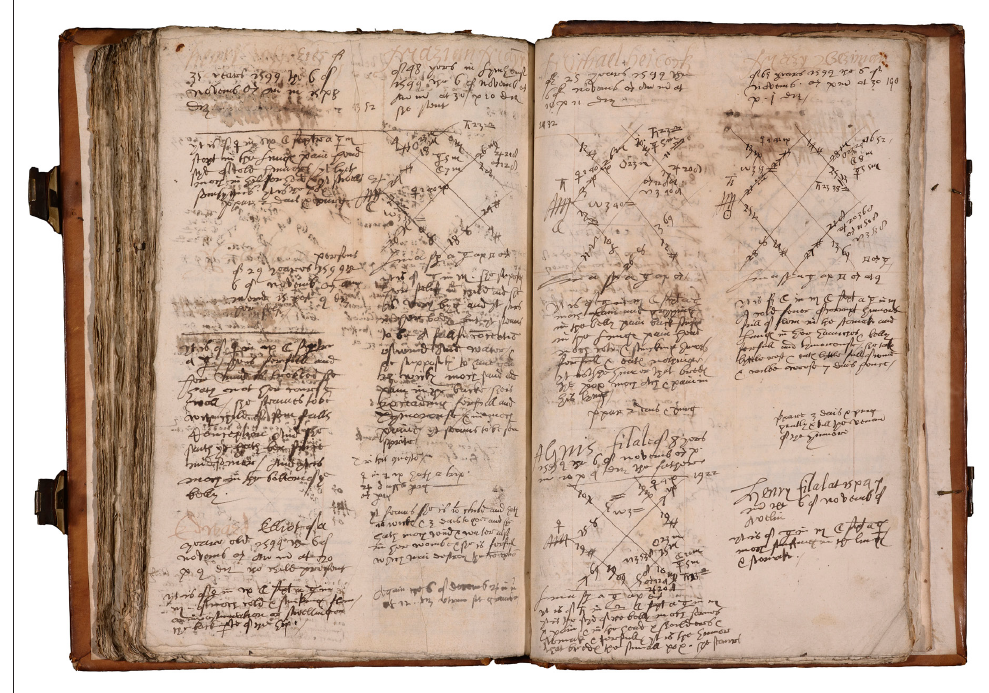
Figure 1: Simon Forman’s casebook open to a page from November 1599. MS Ashmole 219, ff. 189v–90r. © Bodleian Library, University of